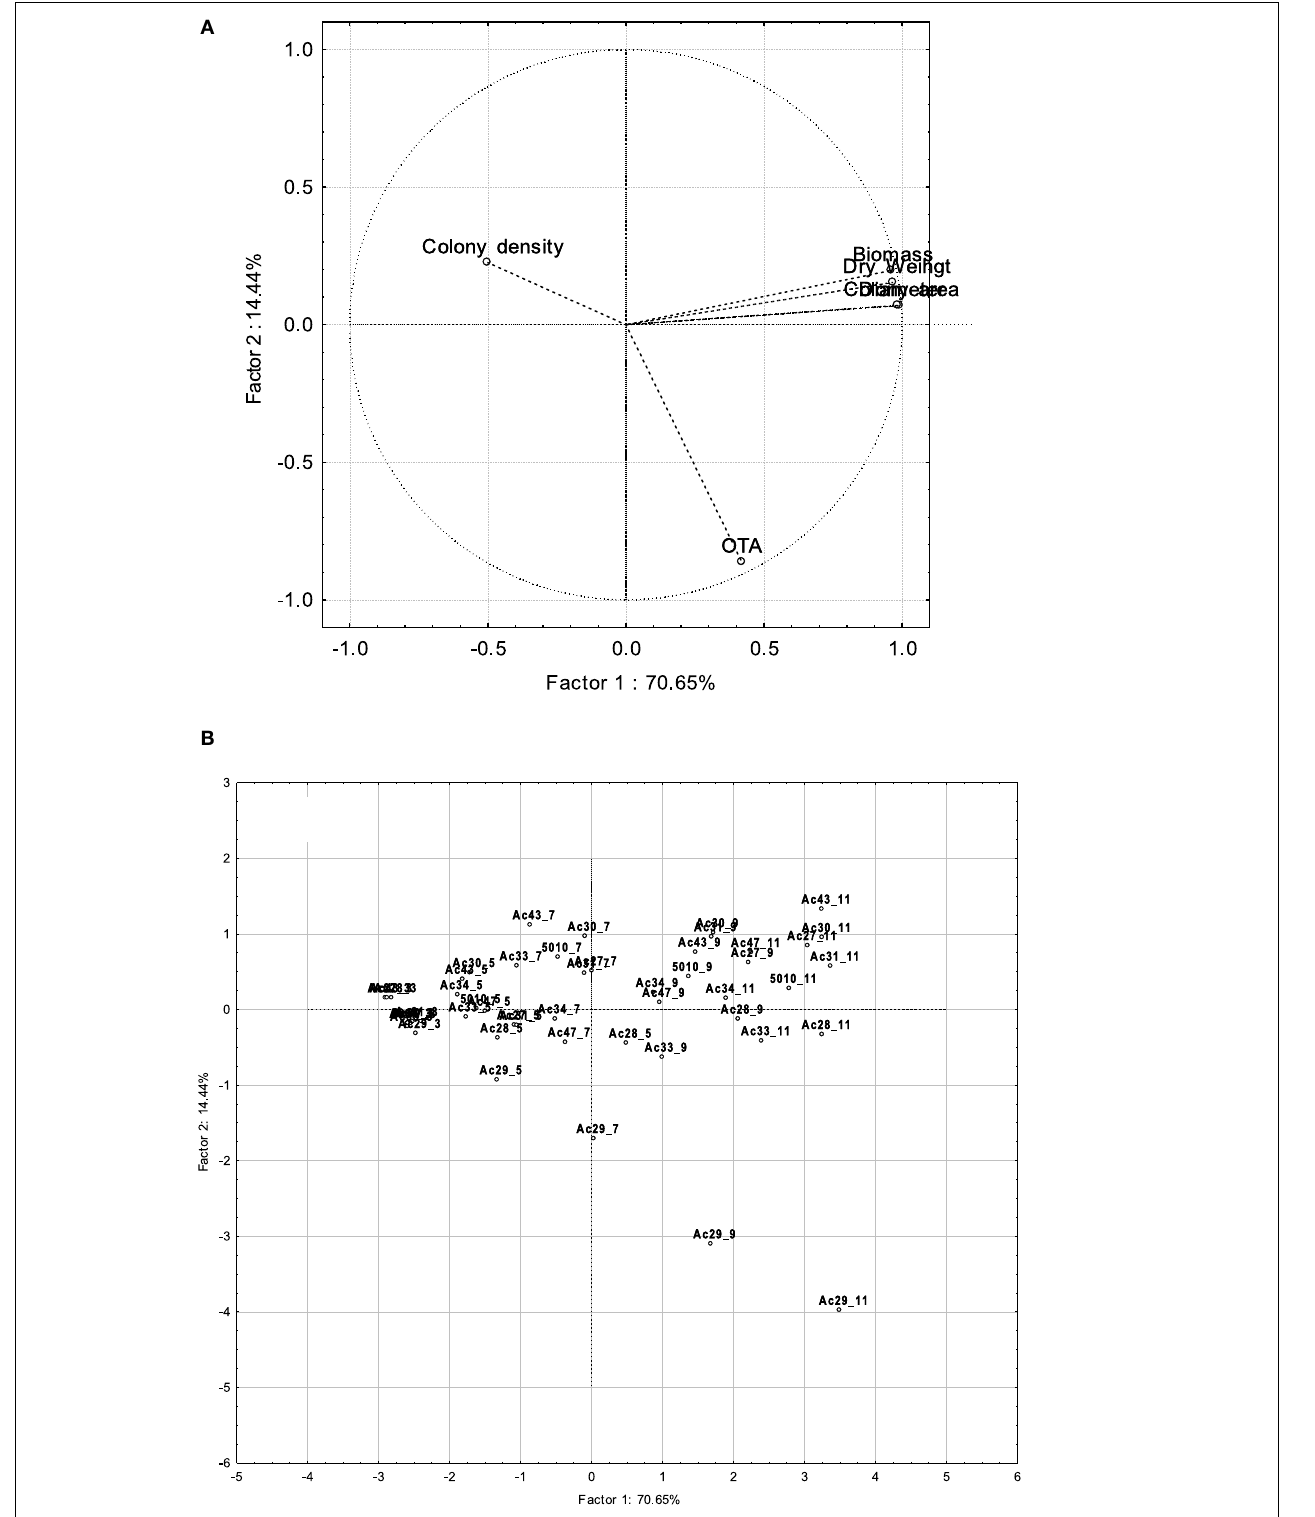
FIGURE 3 | Plot of loadings (A) and scores (B) resulting from PCA analysis for growth and OTA production of A. carbonarius isolates considering time of 5 incubation days.